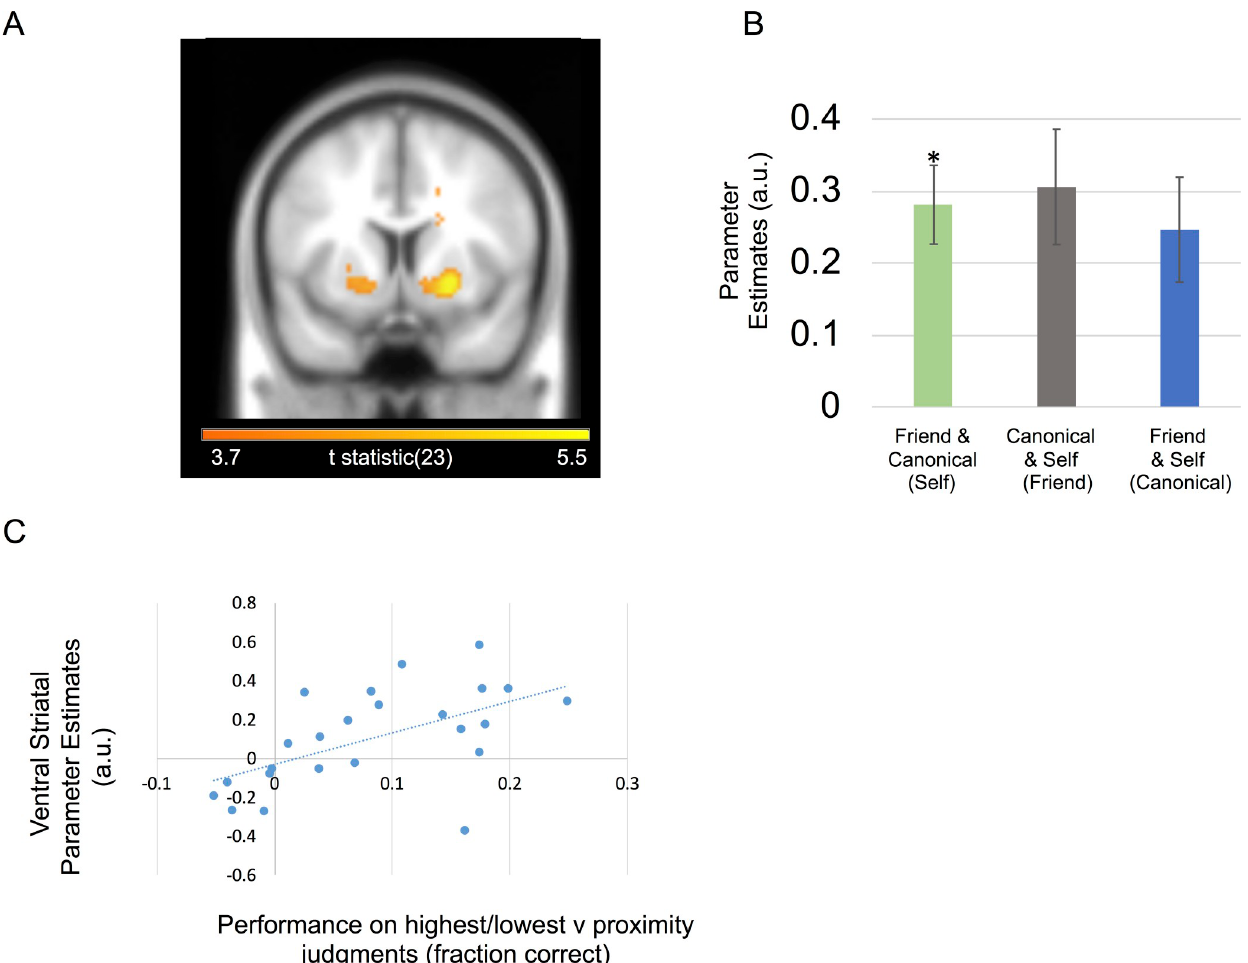
Fig 4. Striatum and decision accuracy. A. Ventral striatal activity related to correct versus incorrect choices. The ventral striatal cluster survived cluster- level FWE correction at P < 0.05 and is displayed at an uncorrected statistical threshold of P < 0.001. B. Effect sizes for a 10-mm sphere around right ventral striatum peak voxel (mean ± SEM). Individuals being compared listed below with anchor in parentheses. A positive effect size indicates a positive BOLD correlation with correct choices. Asterisk marks significance at P < 0.05. C. Plot showing between-subject correlation for subjects’ ventral striatal fMRI signals with behavioral performance. Ventral striatal effects were for highest/lowest judgments versus proximity judgment trials (GLM2). Behavioral performance was taken from subjects’ performance on trials, where highest/lowest judgments could be used, versus their performance on trials where a proximity judgment could be used. Subjects who performed better for highest/lowest judgments exhibited increased ventral striatal activity for the same contrast. See S3 Data for subject data from B and C. BOLD, blood oxygen level-dependent; fMRI, functional magnetic resonance imaging; GLM, general linear